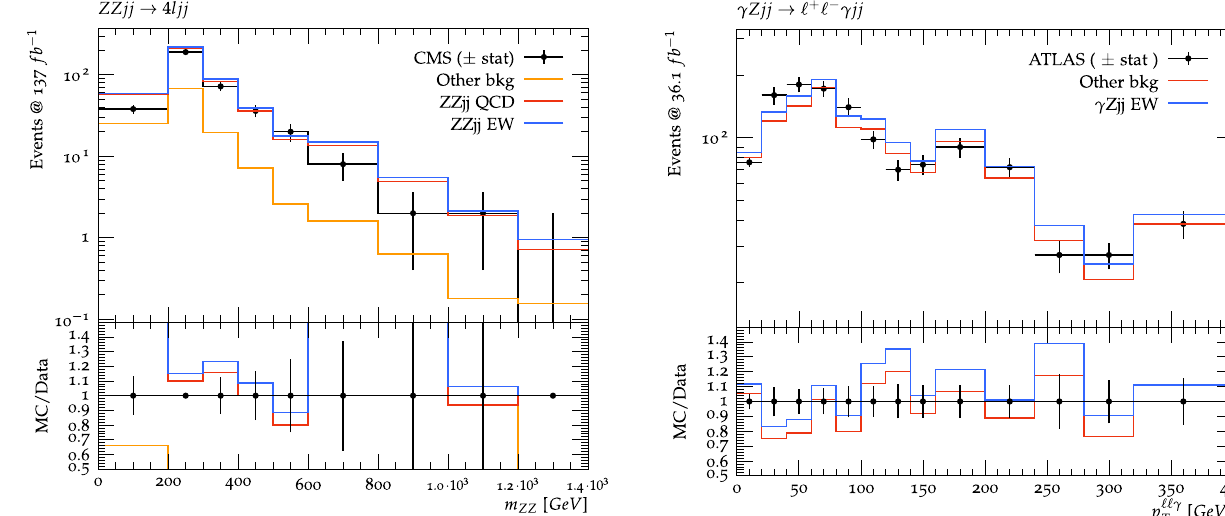
Fig. 7 Comparison between data and theory predictions for the ATLAS measurement of VBS in the γ Zjj final state [20]. Here we (cid:10)(cid:10)γ compare the number of events per p